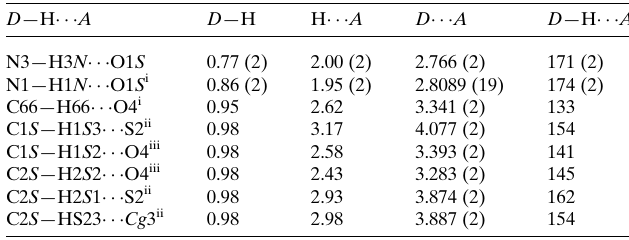
Table 1 Hydrogen-bond geometry (A˚ , (cid:3) ). Cg 3 is the centroid of the C61–C66 phenyl ring.